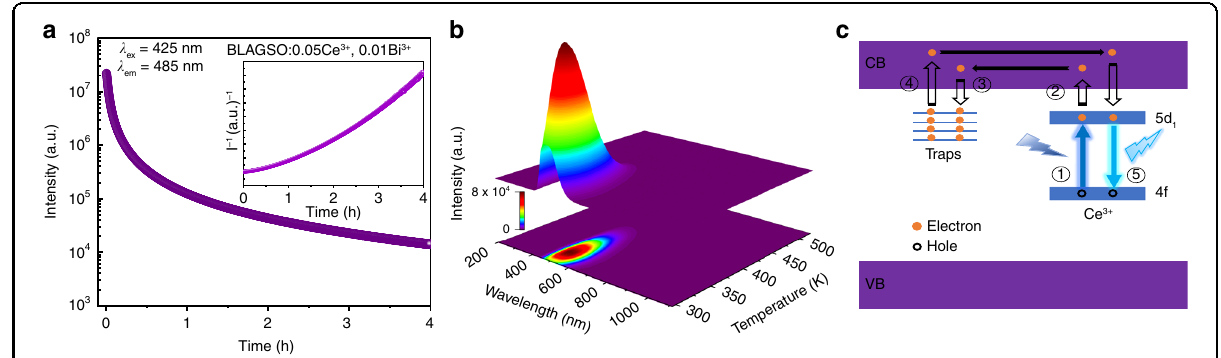
Fig. 7 Persistent luminescence mechanism for BLAGSO:0.05Ce 3 + , 0.01Bi 3 + . a PersL decay curve. Inset: the function of I − 1 versus t . b 3D-TL spectrum. c PersL